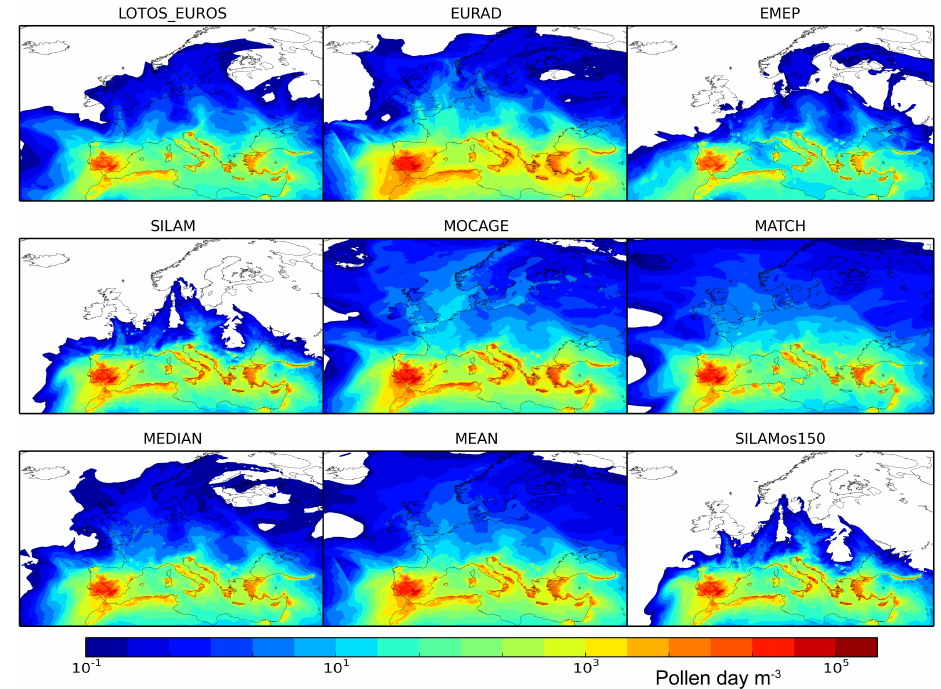
Figure 4. Modelled seasonal pollen index (SPI) by the individual ensemble members and mean models, 2014 [pollen daym − 3 ].